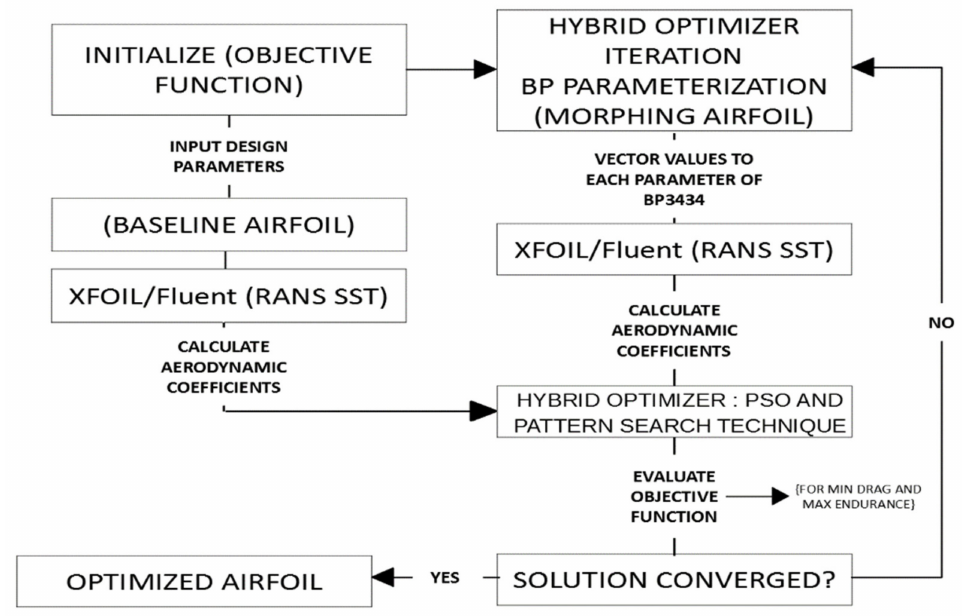
Figure 2. Schematics of the optimization